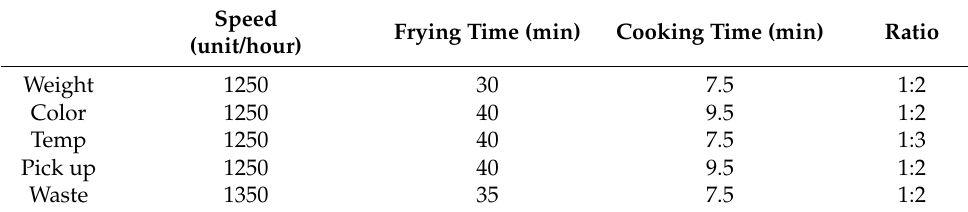
Table 9. The optimal settings for each response.